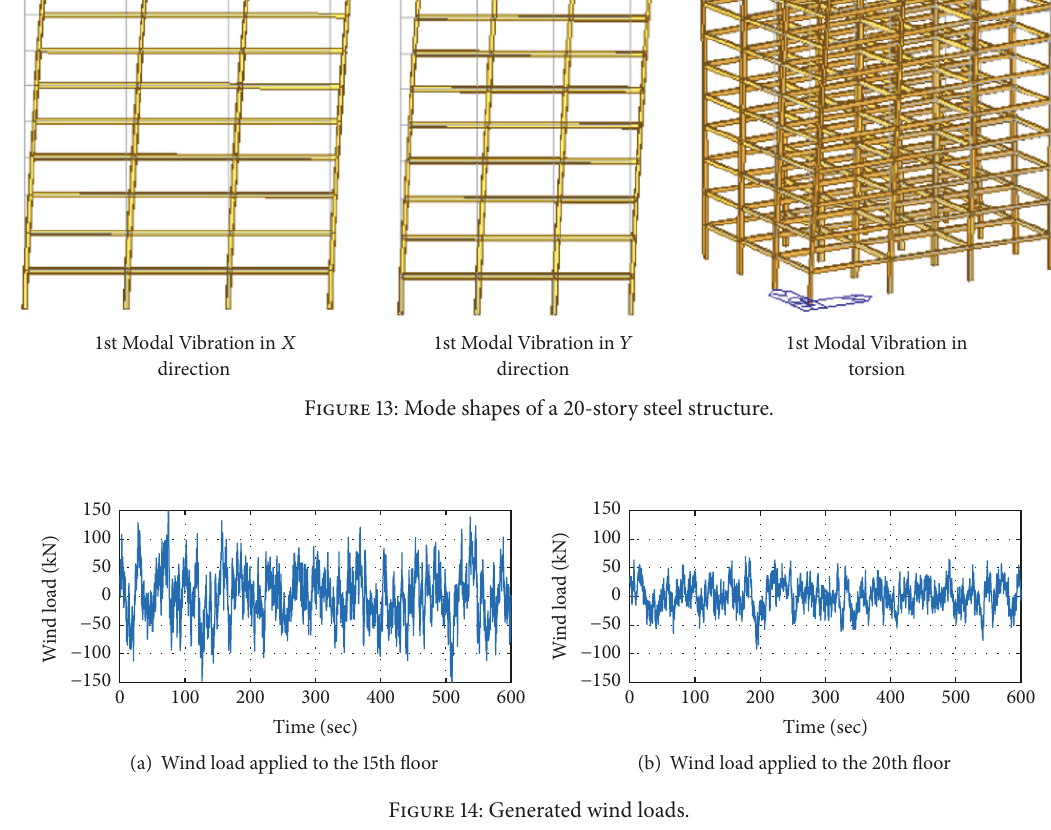
Figure 14: Generated wind